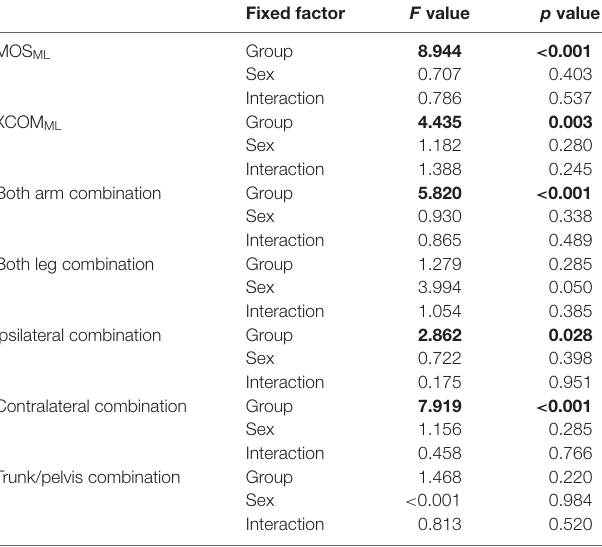
TABLE 2 | Results of two-way analysis of variance for dynamic balance and each coordination.